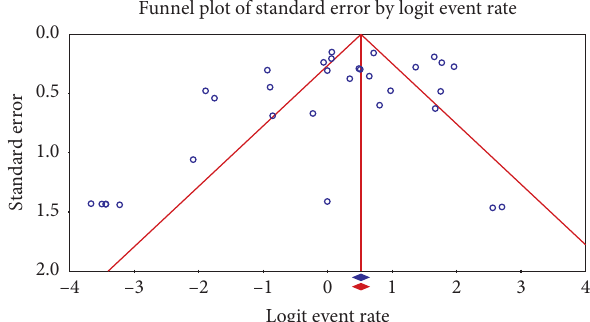
Figure 3: Funnel plot of the meta-analysis of the prevalence of C. coli resistant to ciprofloxacin in Iran.